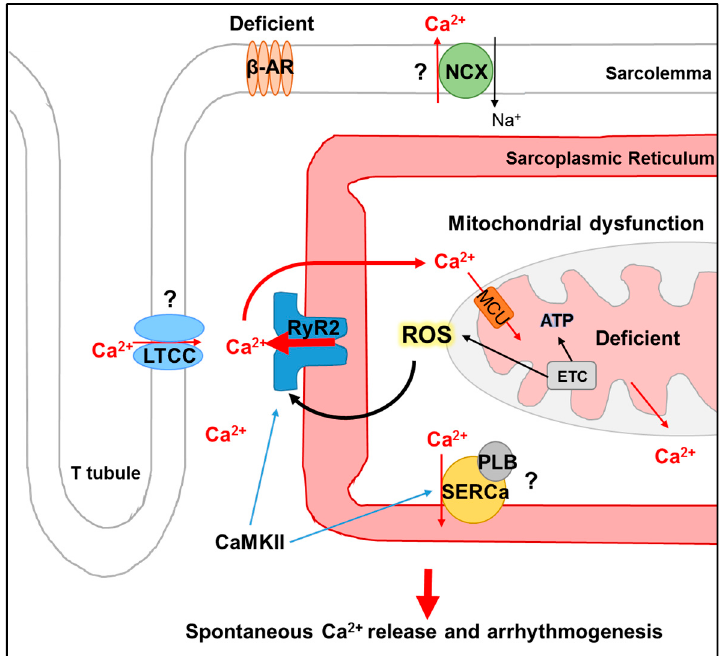
Figure 1. Schematic summarizing the effects of cardiac aging on intracellular Ca 2+ release in senescent myocytes, via a mitochondrial ROS-RyR2 axis. Virtually universal findings in aged myocytes include (1) deficient signaling through β -adrenergic receptors ( β -AR) and (2) mitochondrial dysfunction, including diminished activity of the electron transport chain (ETC) and ATP production, as well an increased ROS emission. (3) It also includes enhanced activity of RyR2, due to oxidation by ROS. CaMKII phosphorylation may also increase RyR2 activity. Increased spontaneous intracellular Ca 2+ release via oxidized RyR2s underlies arrhythmogenesis. Question marks indicate disparate findings regarding the effects of aging on LTCC, NCX, and SERCa2a/PLB function, whereby activity has been reported as unchanged, increased, or decreased. There is some evidence that mitochondrial Ca 2+ levels may be diminished in cardiac aging even though this remains to be fully explored.